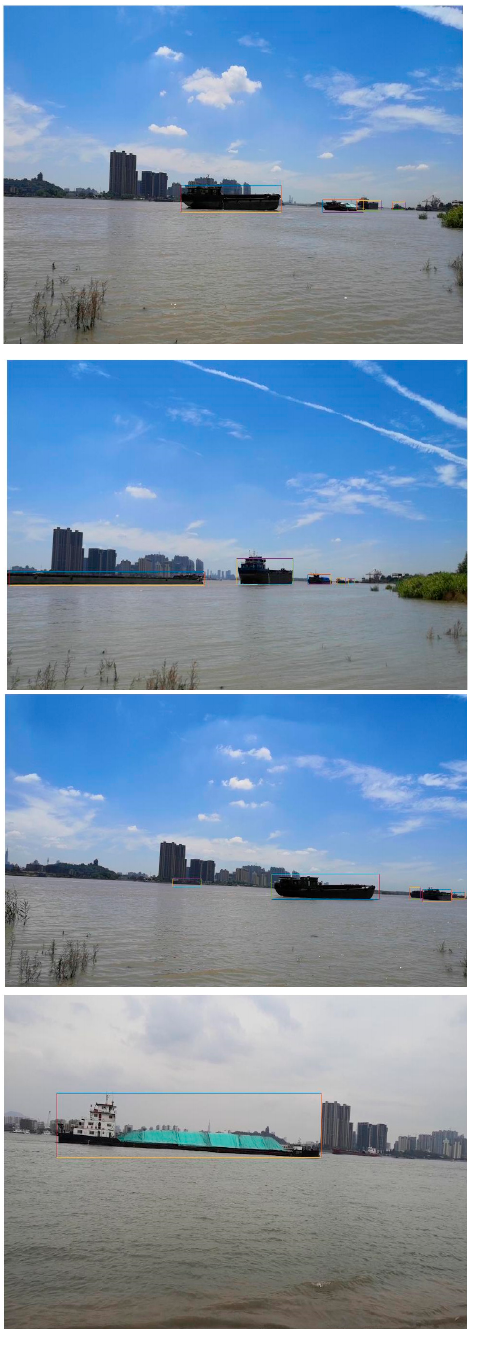
Figure 11. data annotation part of the picture.